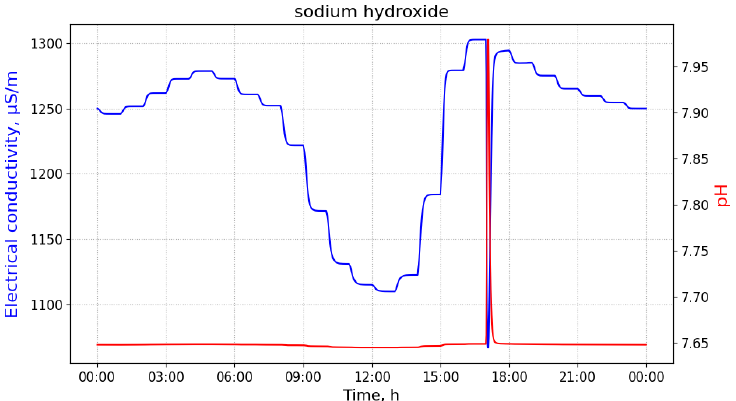
Figure 5. The measurements of pH and electrical conductivity for the utility network content contaminated with sodium hydroxide. Values of the horizontal axis represent time of the day. Measured at the manhole 02, discharged at the building B33 with 100 L of the pollutant at 8 a.m. Contamination with the third and the last substance, sodium sulfate, is characterized by a significant decrease in EC values and a slight oscillation of pH values, as shown in Figure